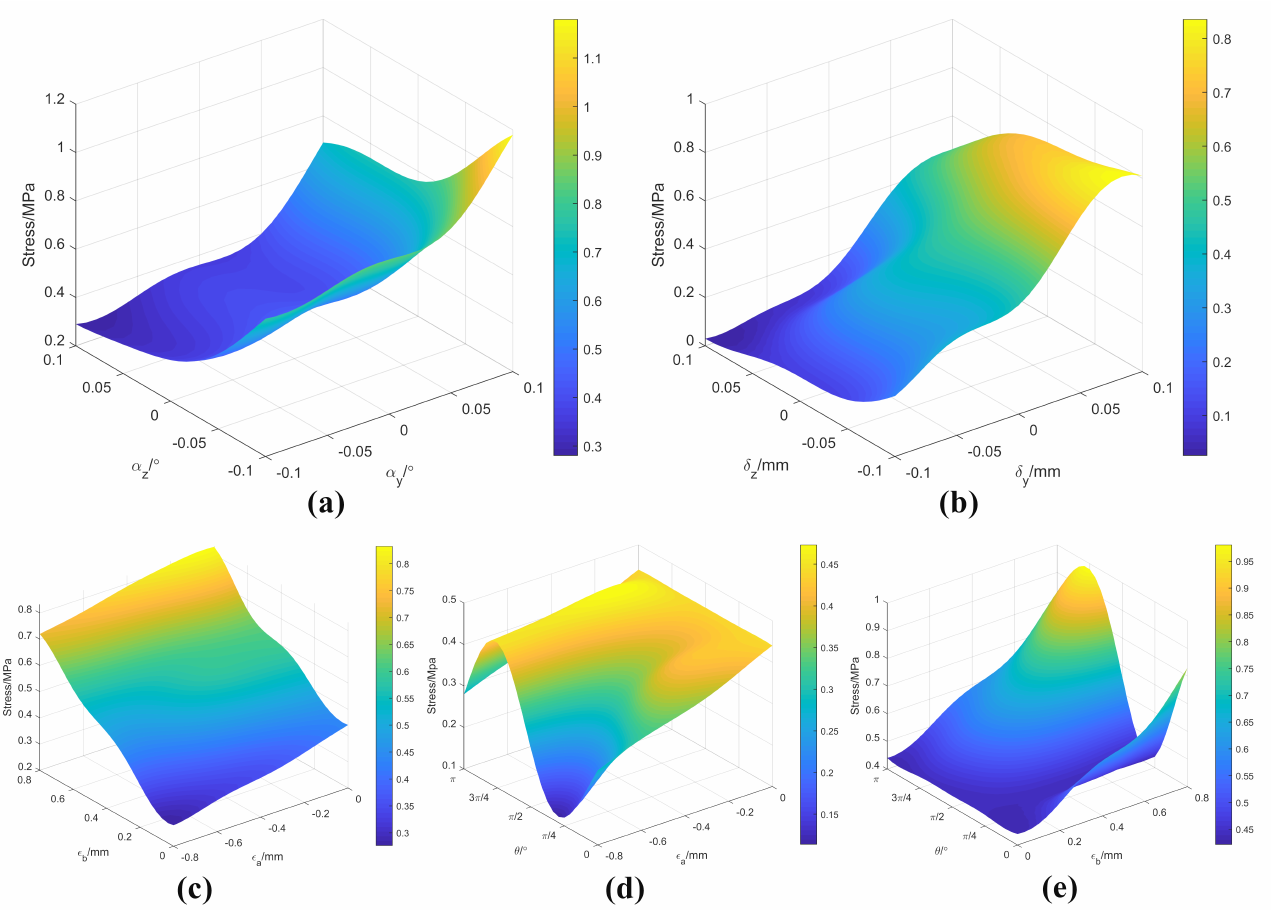
Figure 9. Kriging model of single element: ( a ) Effect of the deflection angle; ( b ) Effect of the eccentric distance; ( c ) Effect of the maximum and minimum elliptical diameter; ( d ) Effect of the maximum elliptical diameter and elliptical angle; ( e ) Effect of the minimum elliptical diameter and elliptical